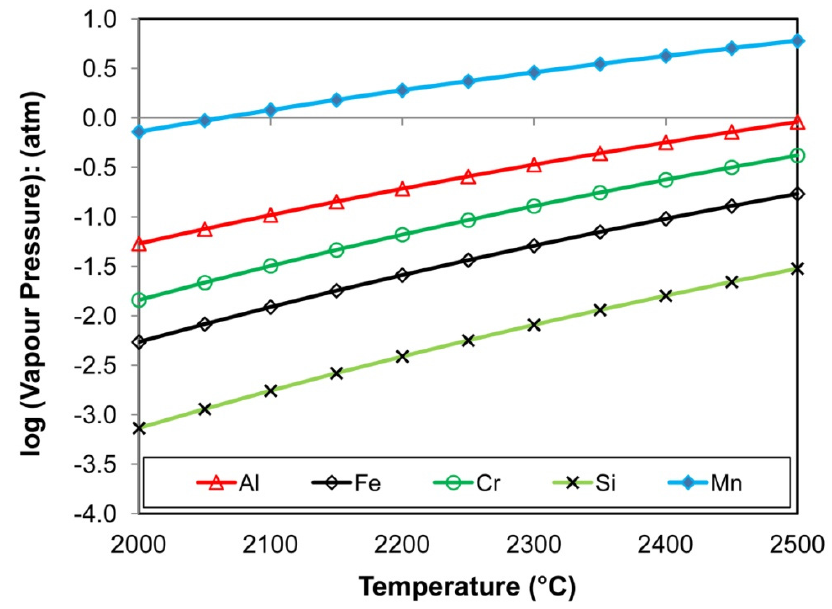
Figure 17. Vapour pressure of Al, Cr, Fe, Mn, Si metal vs. temperature.